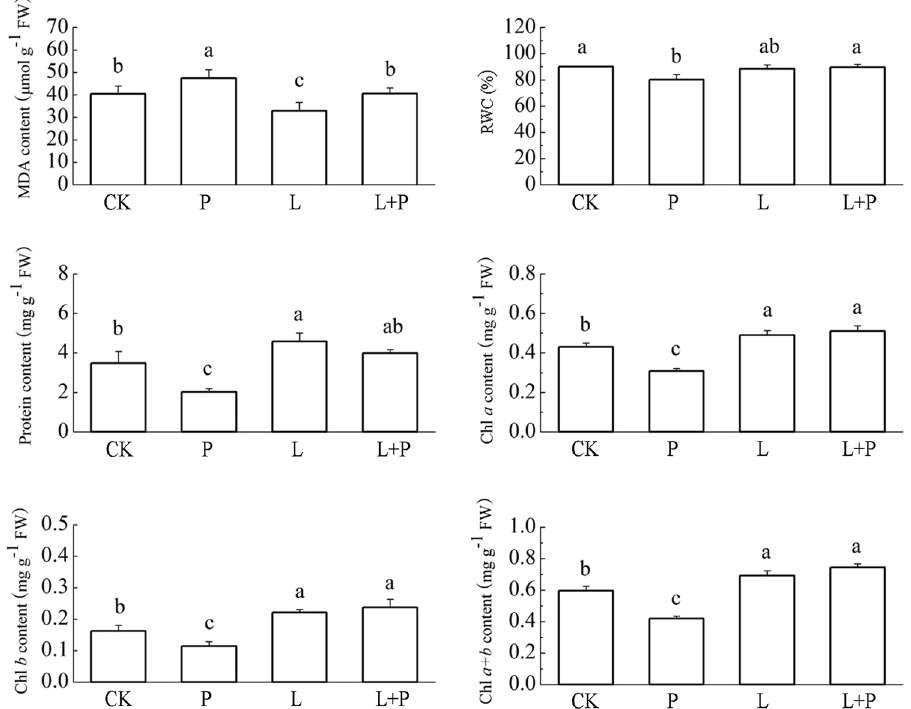
Figure 1. Effect of He-Ne laser pretreatment on the MDA, protein, photosynthetic pigments concentration and the relative water content of the 7-day old seedlings treated with drought stress for 5 days. See notes to Table 1. Bars are means ± standard error of 6 replicates. Different letters above bars indicate significant difference at the 0.05 significant level according to Duncan’s multiple range